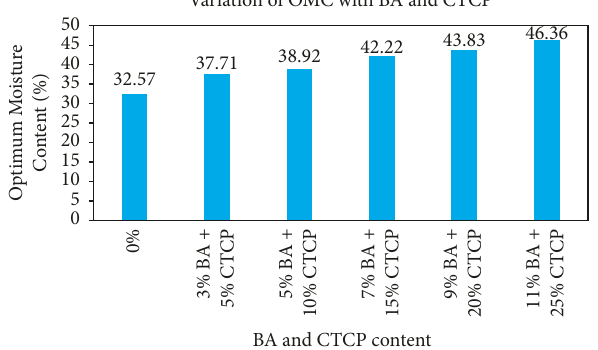
Figure 15: Combined effect of BA and CTCP on OMC.